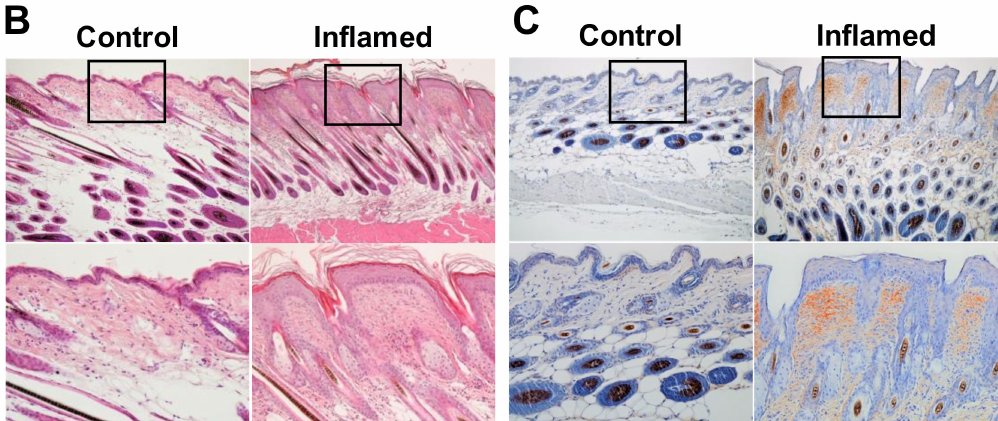
Figure 1. Transcriptional and immunohistochemical analyses of a murine chronic inflammation model. After inflammation or control treatment, all mice were sacrificed. Then the skin tissues were harvested for qRT-PCR and immunohistochemical analysis. ( A ) mRNA expression of inflammatory cytokines ( Il4 , Il5 , Il13 , Il17 , Ifng , periostin ) in control and inflamed mice. ( B ) Hematoxylin-eosin staining of skin in control and inflamed mice. Upper; × 40 magnification. Lower; × 100 magnification. ( C ) Immunohistochemical staining of periostin in control and inflamed mice. Upper; × 40 magnification. Lower; × 100 magnification. t -test; * p < 0.05. Each group consisted of eight mice. Representative data of three independent experiments are shown.